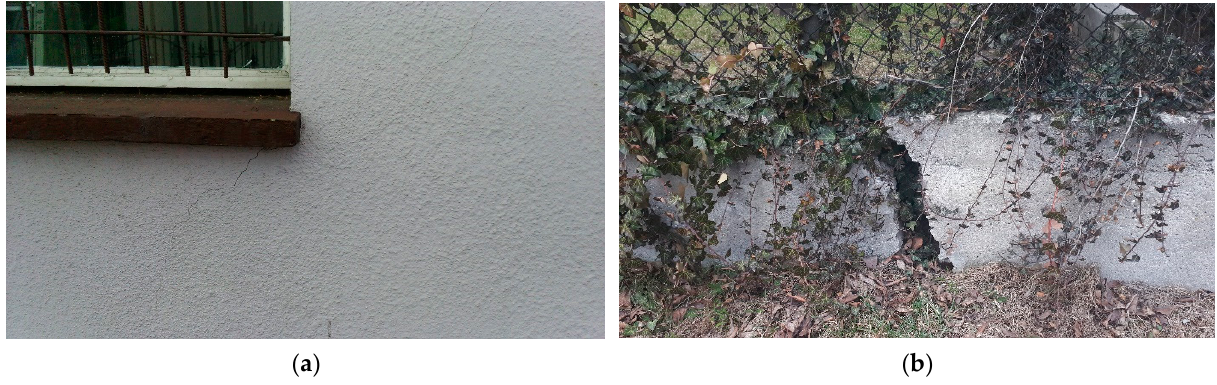
Figure 5. Damage outside the building: ( a ) a scratch near window in the east wall; ( b ) a crack of base of the fence.